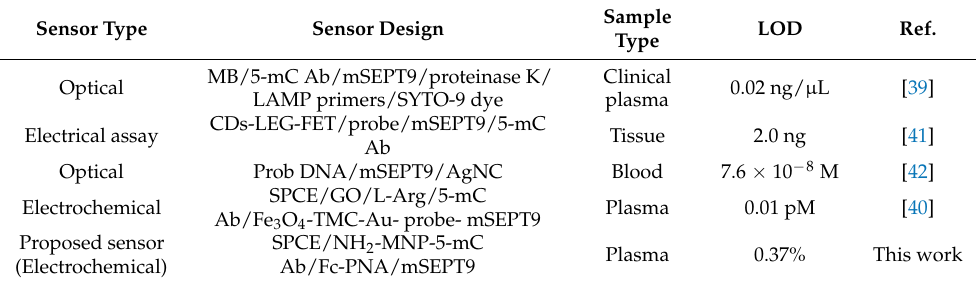
Table 3. An overview of existing mSEPT9 sensors in the literature.